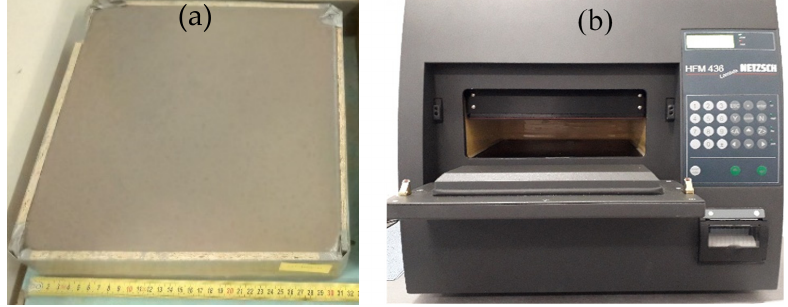
Figure 2. Sample GP ( a ), and thermal conductivity device: HFM436 Lambda ( b ).